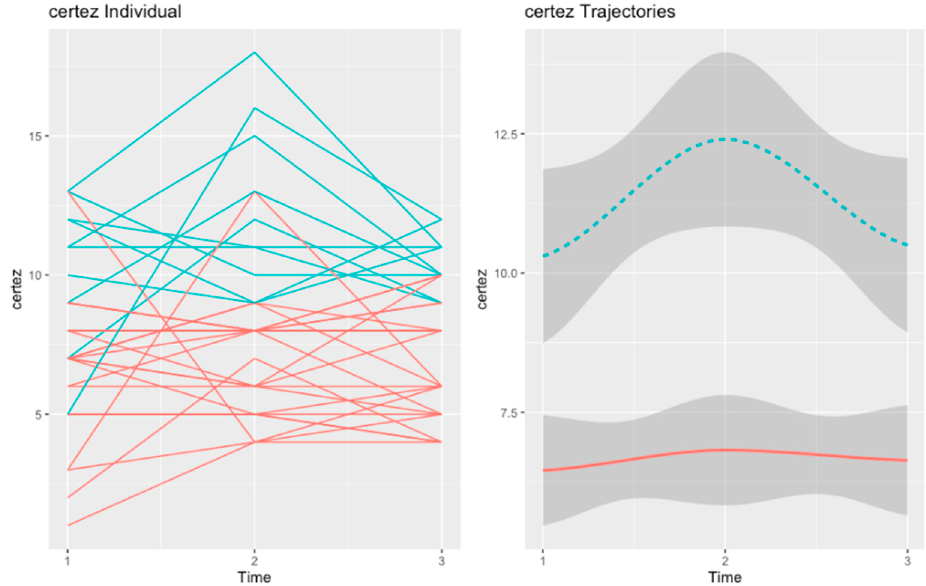
Figure 4. Trajectories of self-certainty in the psychoeducation group. In red is depicted the “Low and Stable SC” (n = 23) trajectory. The second trajectory, in blue, refers to the “Worsening SC” (n = 11) trajectory.